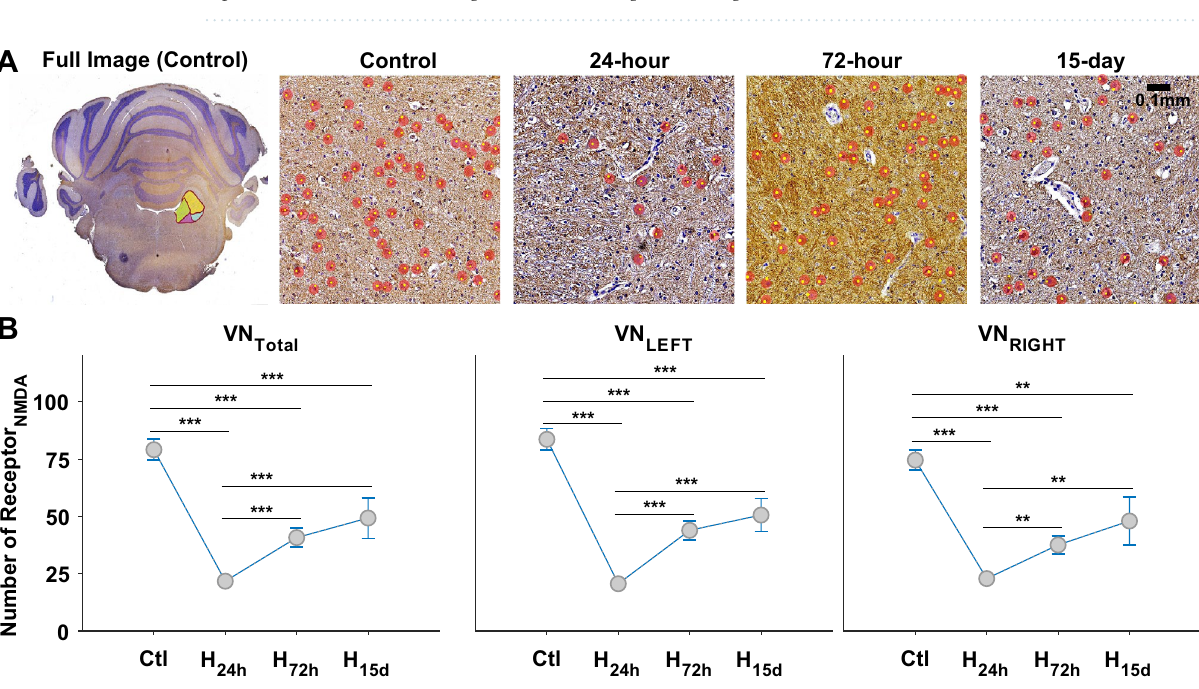
Figure 6. A full coronal image of the brain with the position of vestibular nucleus (VN), and the detected NMDA receptors (NMDAr) in control, 24-h, 72-h, and 15-day ( A ). Total number of NMDAr in overall, left, and right sides of VN ( B ). The significance was symbolized as done in Fig. 5 (*0.01 < p < 0.05, **0.001 < p < 0.01, *** p <